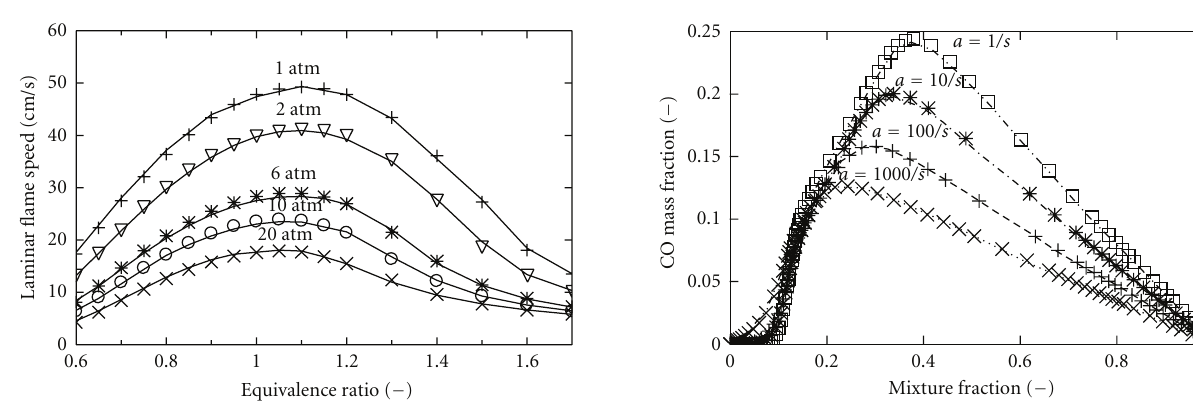
Figure 4: Comparison of computed CO mass fractions versus mixture fraction for a Tsuji burner at strain rates a = 1 /s , 10 /s , 100 /s , 1000 /s . Lines: detailed DME chemistry by Zhao et al. [10]; symbols: 28-species reduced chemistry (this work).